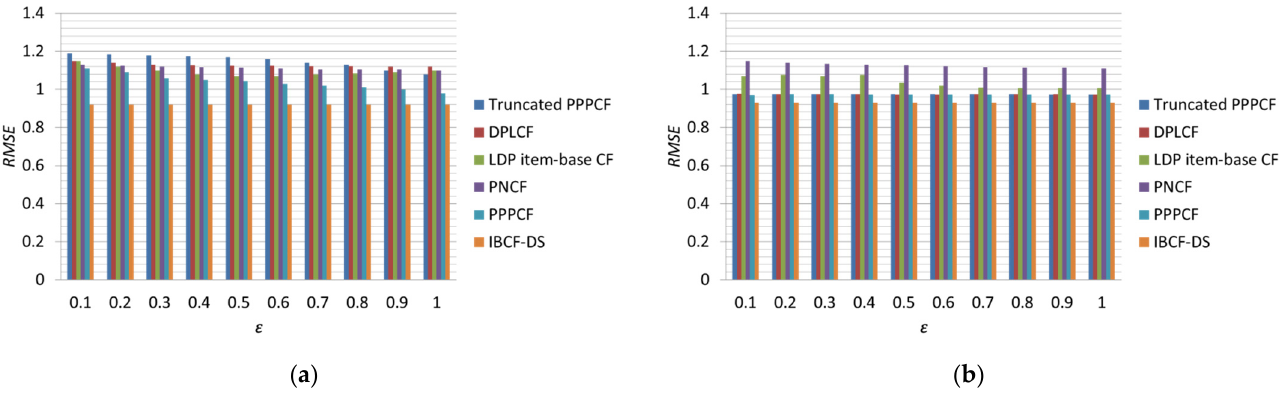
Figure 5. RMSE of each algorithm with different privacy budgets 𝜀 . ( a ) Movielens 1M; ( b ) Yahoo Music.